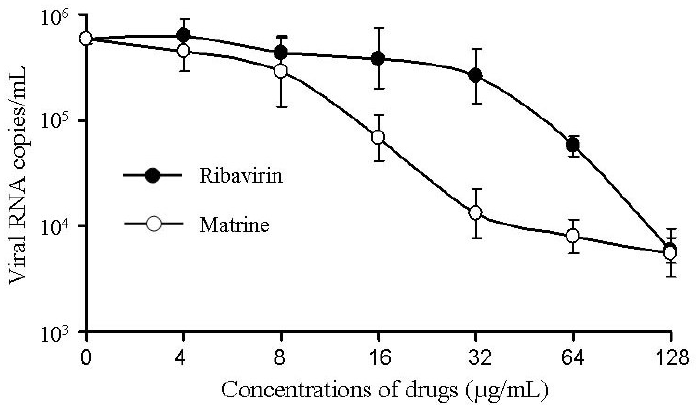
Figure 2. The viral RNA copies in culture supernatant of RD cells treated with matrine at 28 h post infection were detected by qRT-PCR.